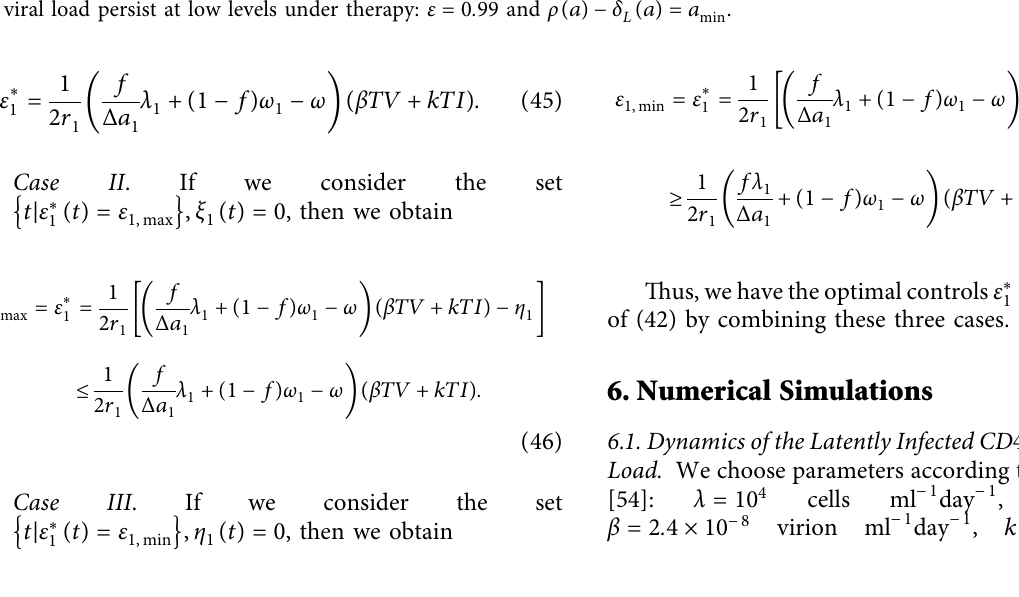
� 0 . 01day − 1 . (b) The latently infected CD4 + , where a min min . (c) The latently infected CD4 + Tcells min min